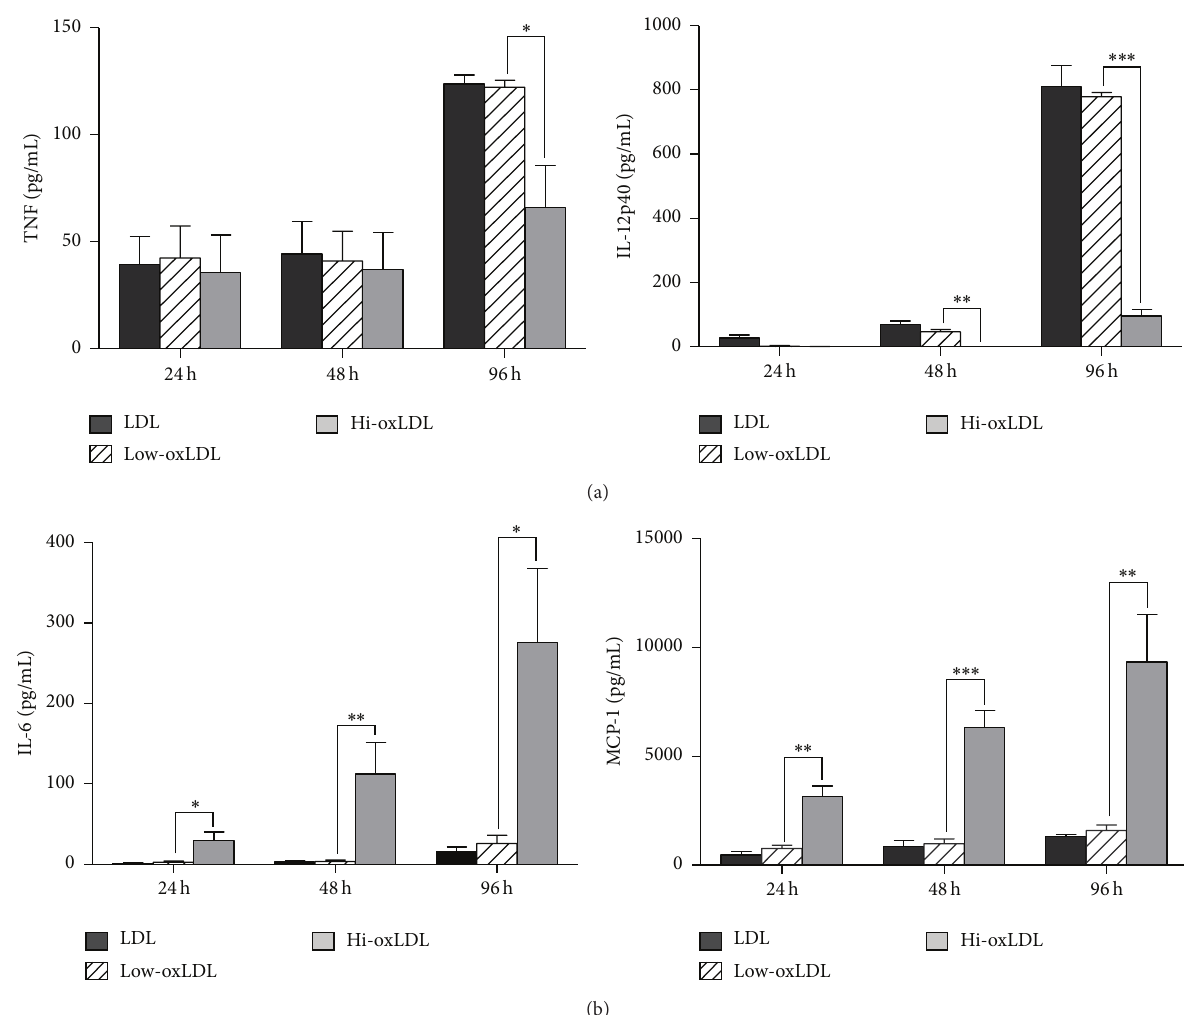
Figure 3: Production of cytokines and chemokines in response to oxLDL. THP-1 cells were pretreated with differentially oxidized LDL (50 𝜇 g/mL) for 24, 48, or 96 h and treated with LPS (100ng/mL) for 18h. Culture supernatants were harvested and the levels of TNF- 𝛼 , IL- 12p40, IL-6, and MCP-1 were measured by ELISA. Data represent means ± S.E. of three independent experiments. One-way ANOVA analysis was used to determine significance ( ∗ 𝑝 < 0.05 , ∗∗ 𝑝 < 0.01 , and ∗∗∗ 𝑝 < 0.001